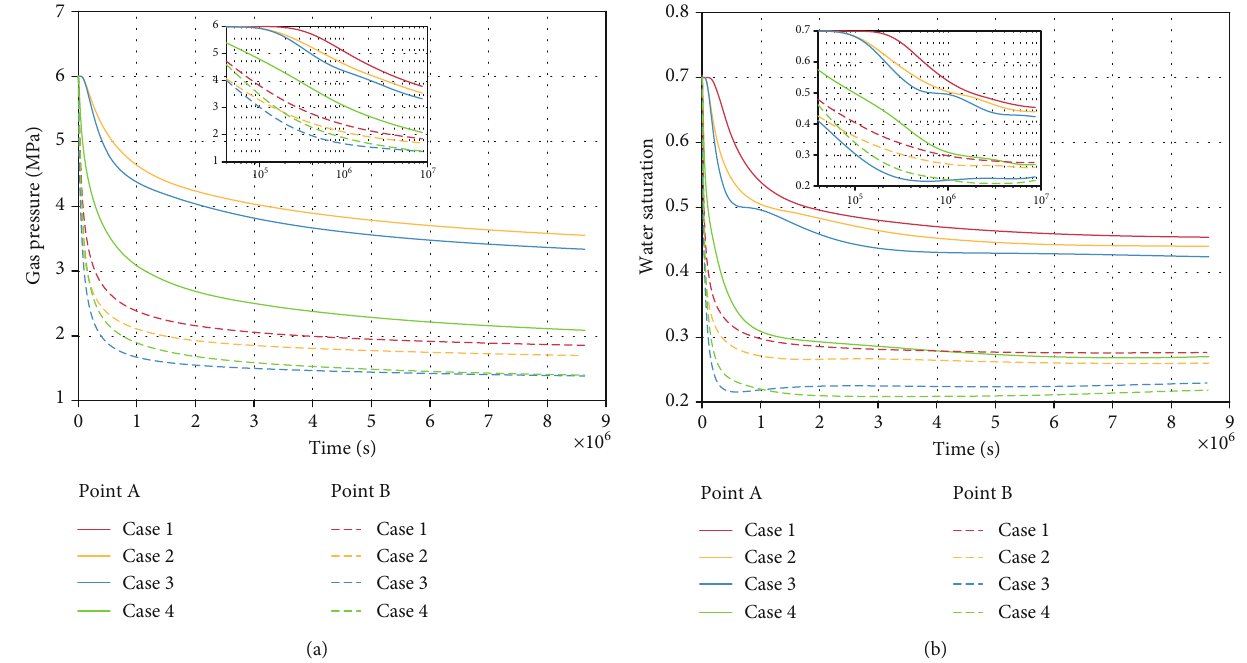
Figure 10: Temporal evolution of (a) gas pressure and (b) water saturation at points A and B for the four cases. Solid and dashed lines represent the results at points A and B, respectively.